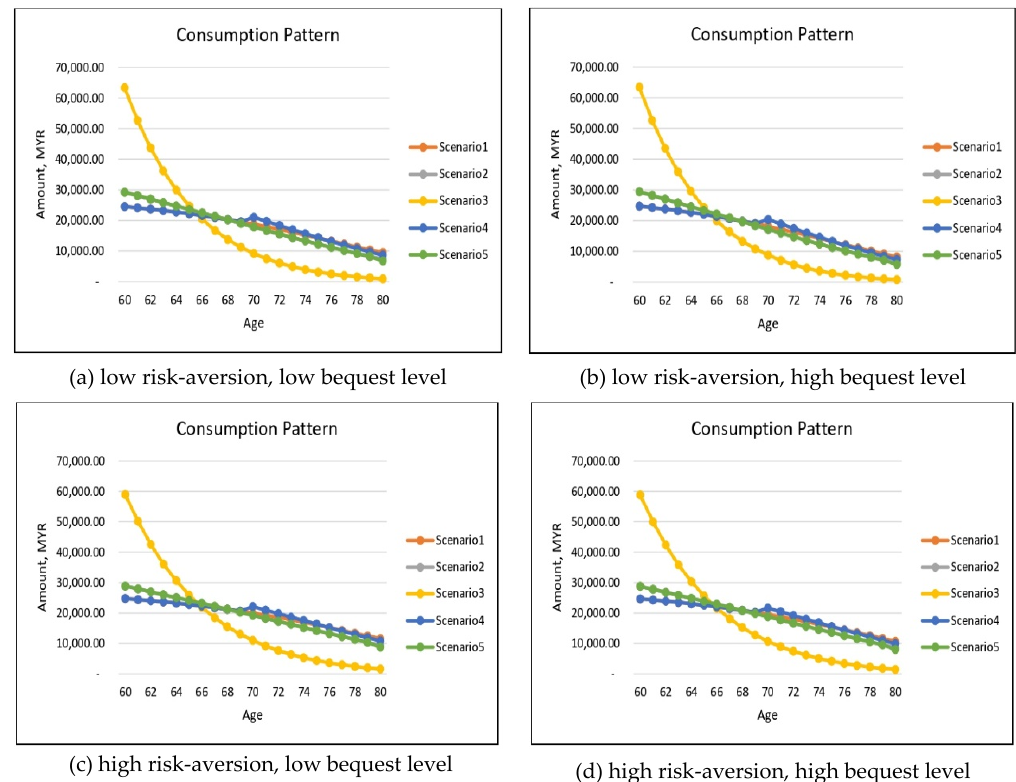
Figure 8. Optimal Consumption Pattern for Males (Health-Dependent Utility).